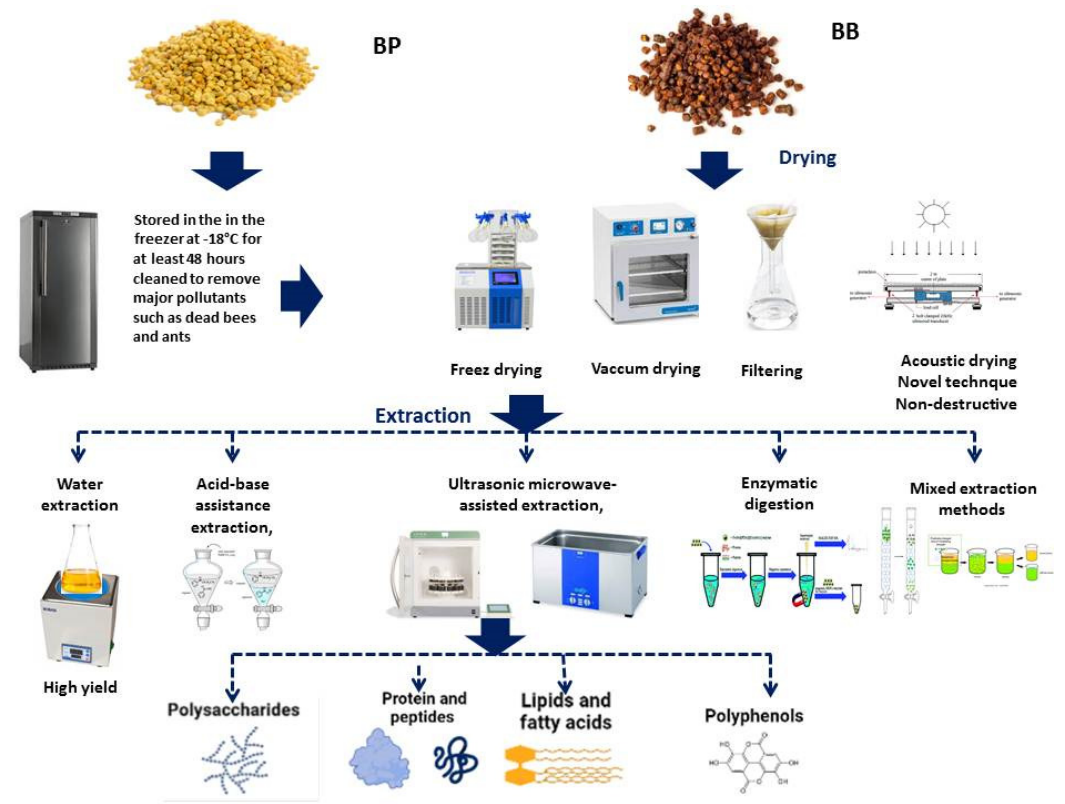
Figure 4. Schematic presentation of the stages of drying and extraction of bee products prior to the isolation of their bioactive metabolites.